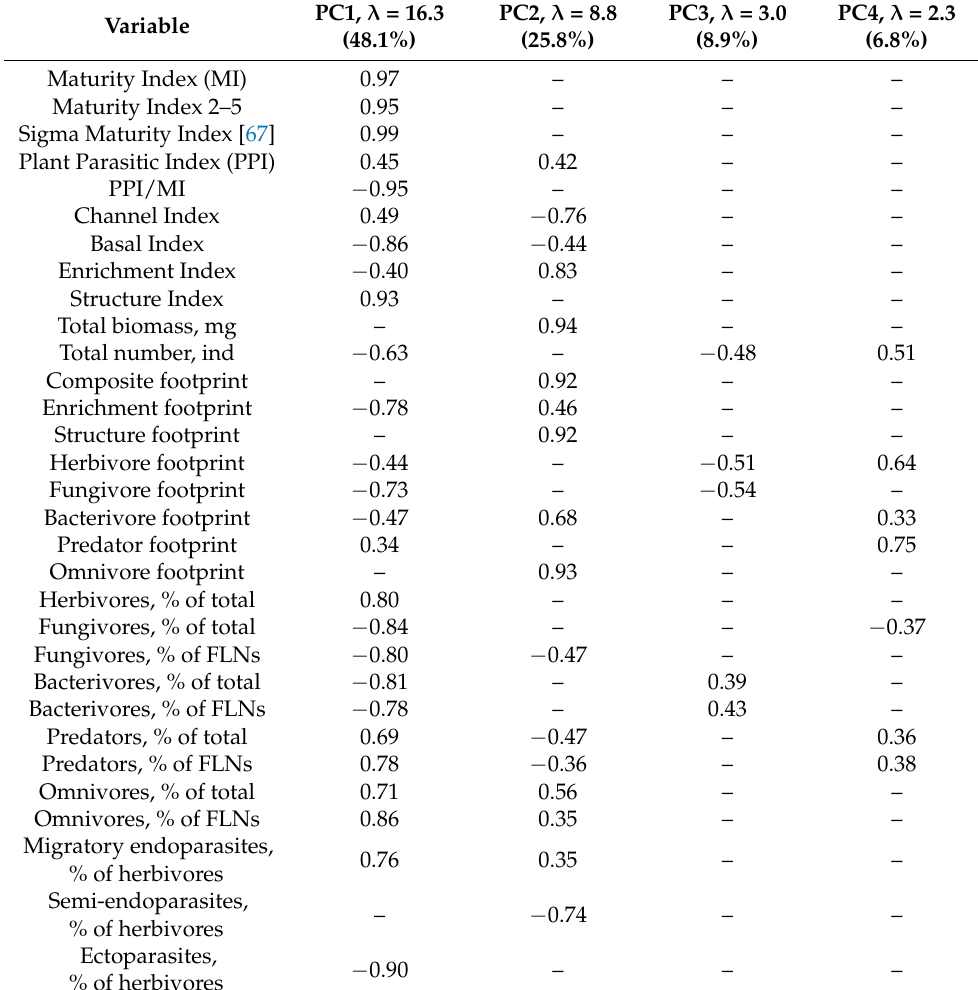
Table 6. PCA of variation in the synecological characteristics of nematode communities.